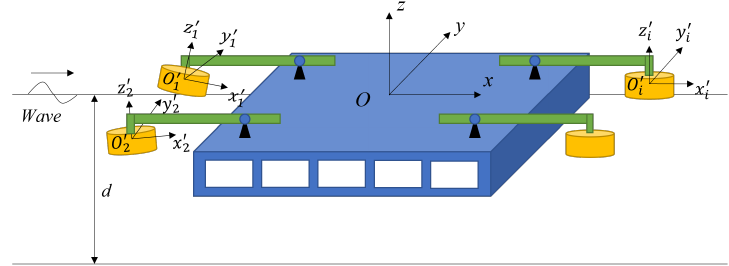
Figure 1. Sketch of the wave and multi-floater truss-type WEC